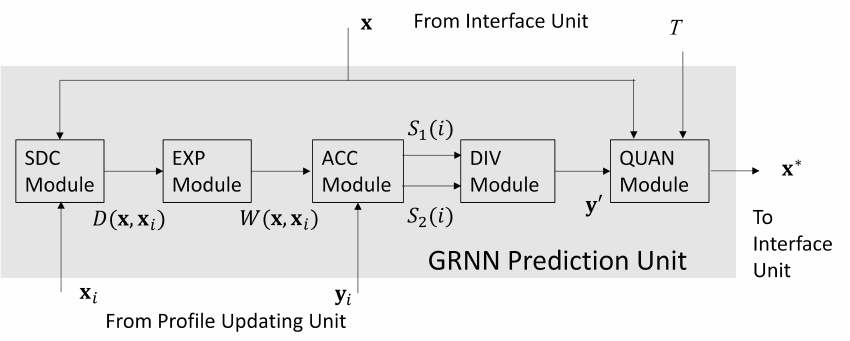
Figure 3. The architecture of the GRNN prediction unit.